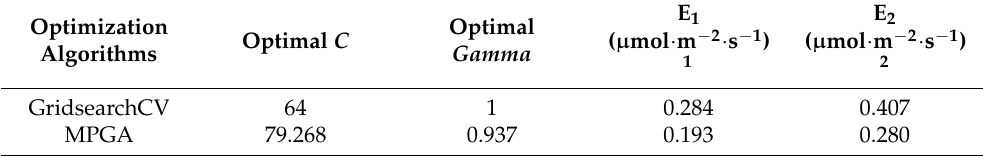
Table 4. Comparison between Gridsearch CV and MPGA optimization